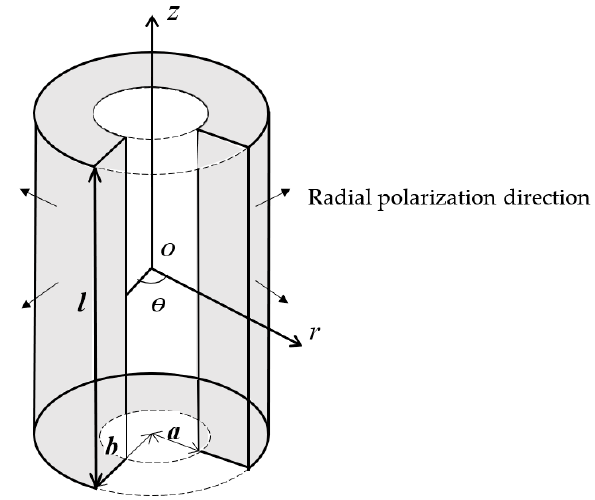
Figure 1. A radially polarized piezoelectric cylindrical transducer.